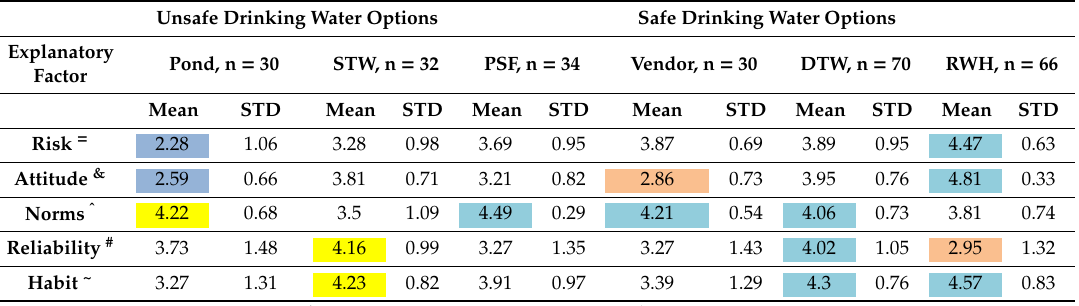
Table 3. Standardised mean values of the explanatory factors. For the unsafe drinking water options, the facilitators (values lower than 3) are highlighted in blue, while the barriers (values higher than 4) are highlighted in yellow. For the safe drinking water options, barriers (values lower than 3) are highlighted in orange, while opportunities (values higher than 4) are highlighted in teal. As a reminder, the operationalisation of the factors is summarised below the